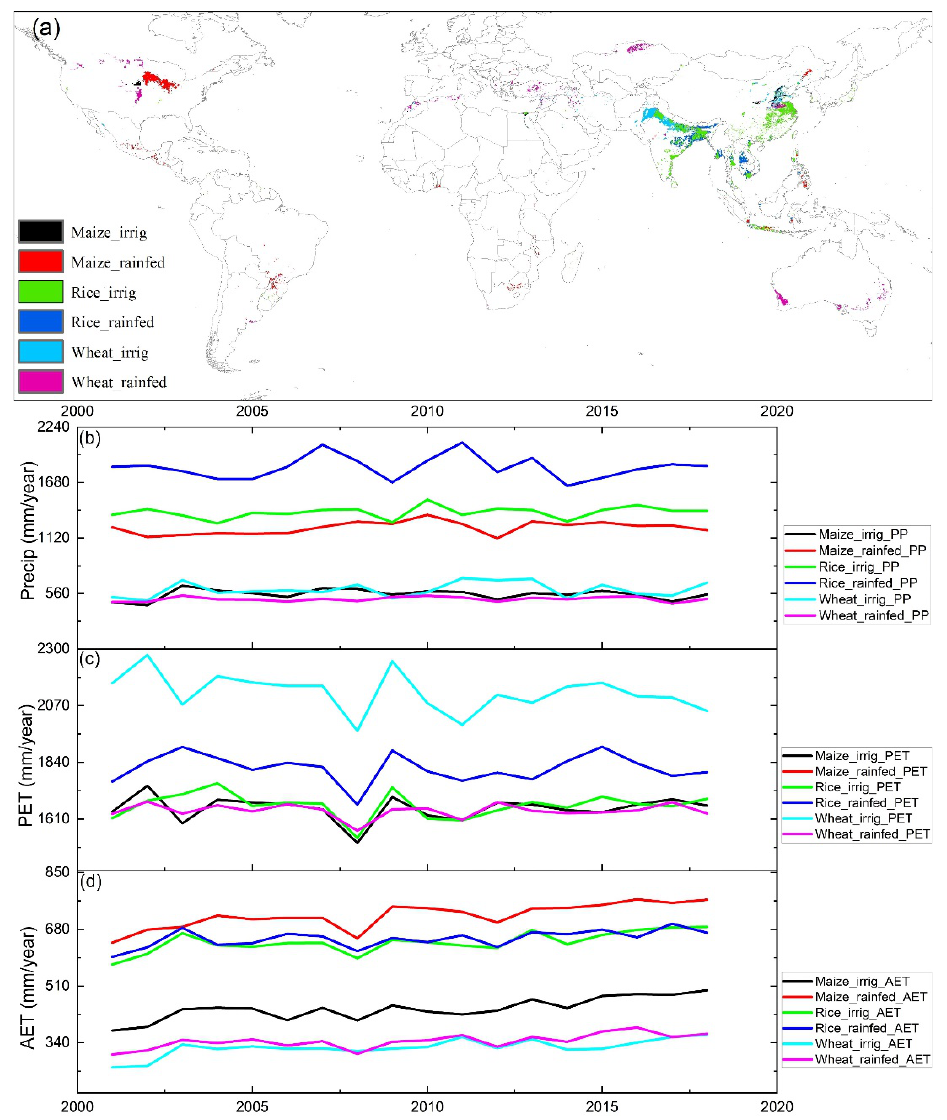
Figure 9. Time series of annual AET, PET, and PP averaged over major rainfed and irrigated croplands.